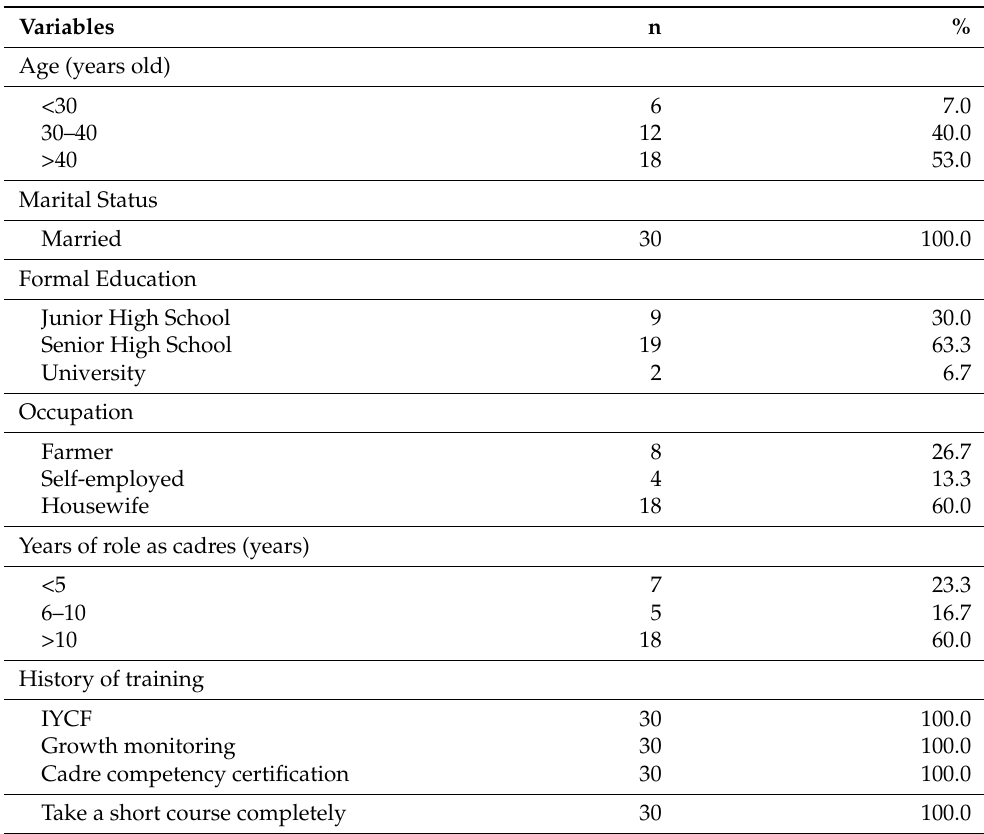
Table 1. Characteristics of